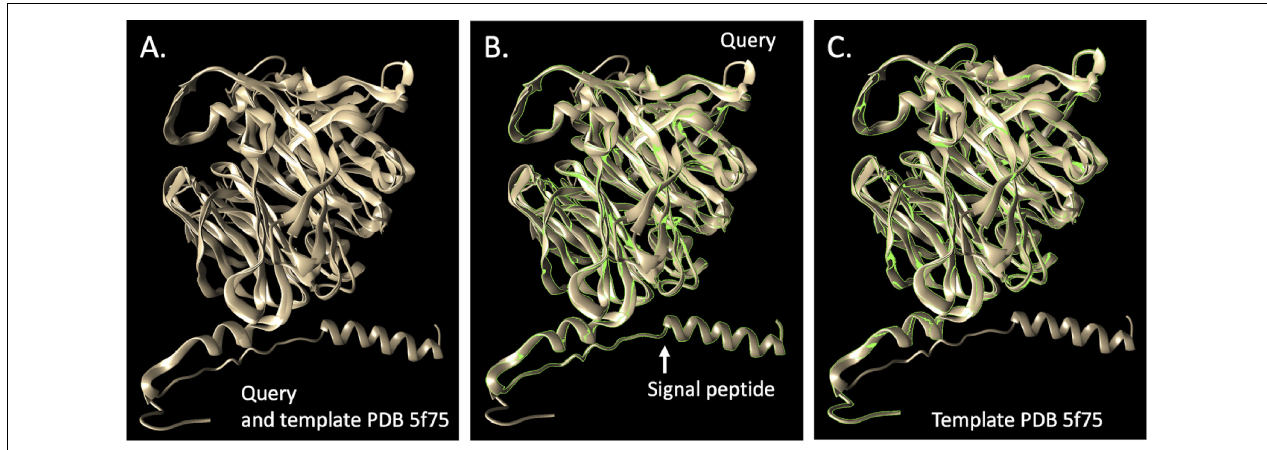
FIGURE 4 | Comparison of the putative thiocyanate desulfurase (EC 1.8.2.7) from Afipia_64_1782 and the most closely related protein, Model 5F75 (Tsallagov et al., 2016), in the PDB. (A) shows the query superimposed upon the template, (B) shows the query and (C) the template. The TM-score of the structural alignment between the query and 5f75 was 0.901, compared to the second choice score, PDB 2ECE (Yamada et al., 2008), a hypothetical selenium binding protein from Sulfolobus tokodaii of